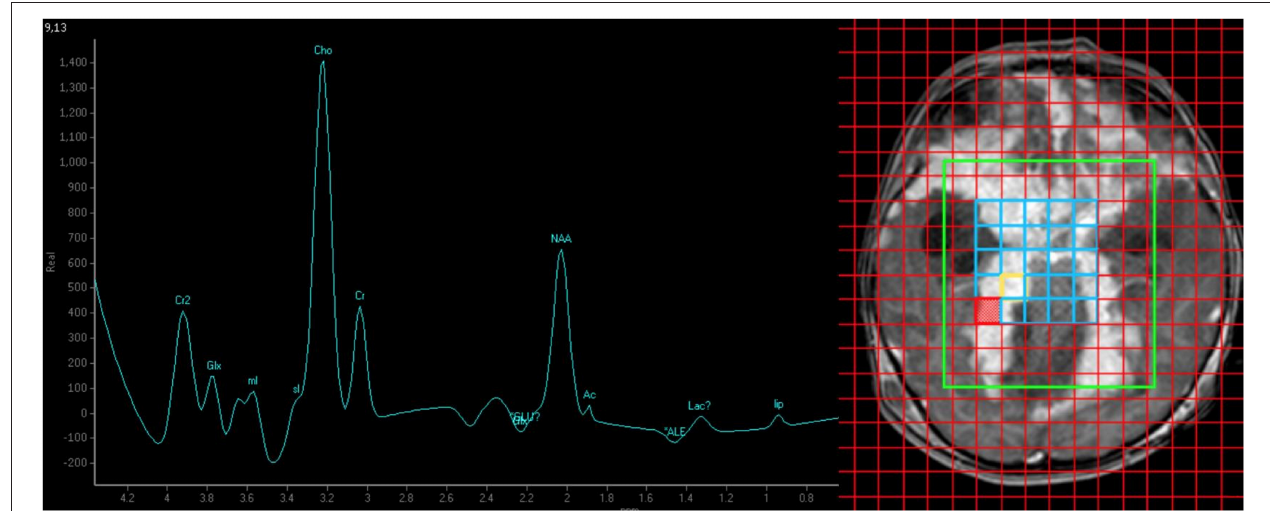
FIGURE 3 | MR spectroscopy (TE/TR = 144 ms/2,000ms) findings of elevated choline:creatine ratio (4.34) suggesting high cell turnover in favor of malignancy. The absence of a singlet peak at 3.8 ppm makes tuberculoma less